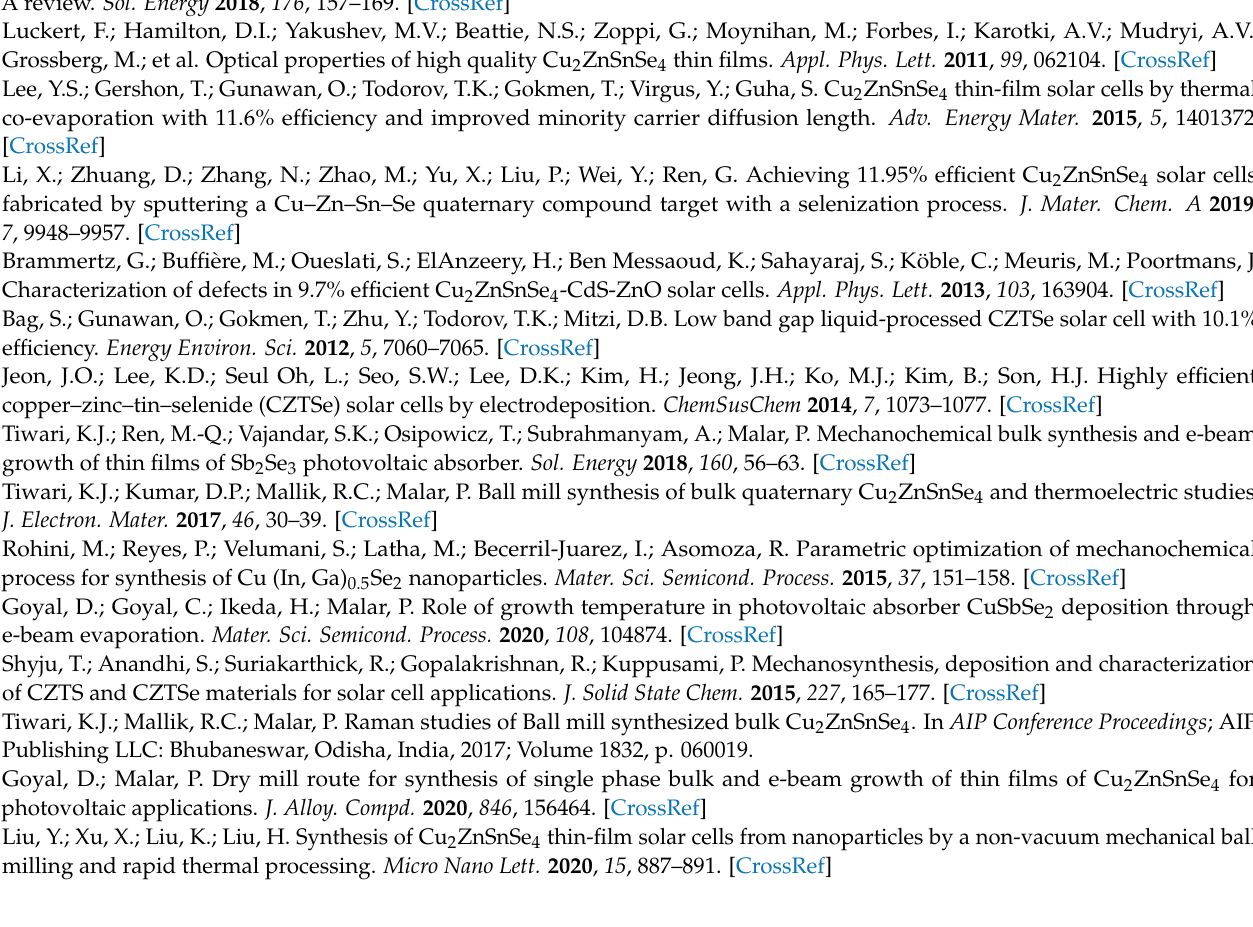
Table S5: Elemental composition of CZTSe with the sodium layer. References [59–62] are cited in the Supplementary